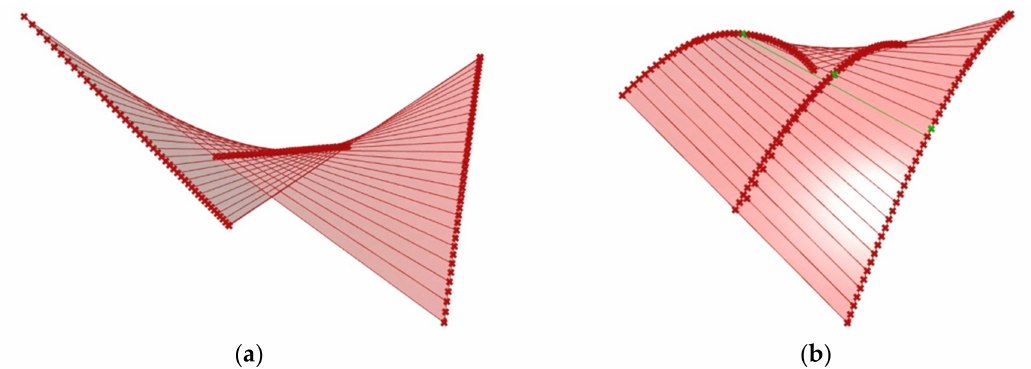
Figure 18. Simplified, smooth models of two transformed shells built in the Rhino/Grasshopper program and defined with: ( a ) straight directrices; and ( b ) curved directrices.